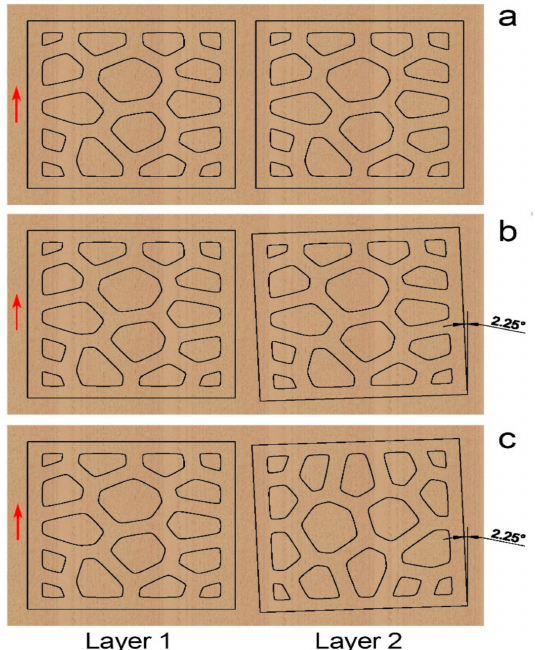
Figure 7. Wood-texture direction (indicated by red arrows) and distinct layer-cutting solutions ( a ) Cutting solution with identically cut layer 1 and layer 2. The resulting wood texture directions of the structure are 2.25 ◦ between each layer. ( b ) Cutting solution that produces a product with a consistent wood texture direction. ( c ) Cutting solution that produces a product with orthogonal wood texture directions between